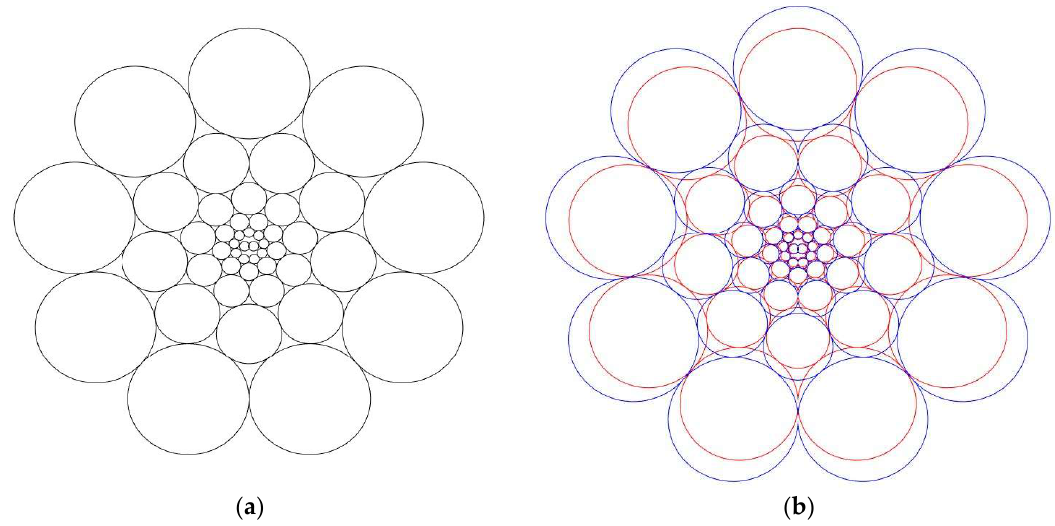
Figure 15. ( a ) Illustration of the layout of receptive fields (RFs) for a transformation with a small number of wedges; ( b ) Same transformation shown in ( a ) (in red) with an additional transformation (in blue) whose only difference is an increase in the minimum RF size relative to that of the red transform. This illustrates the increase in the spatial support of the foveal region from one transform to the other.